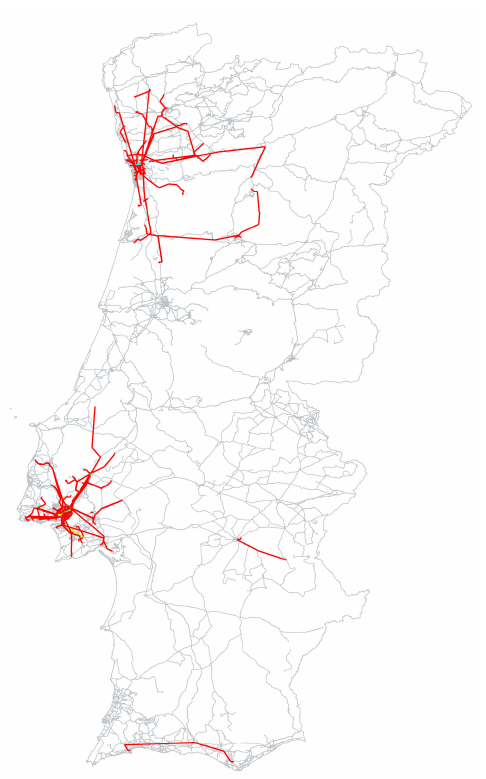
Figure 24. Ground-truth commuting route choices of 90